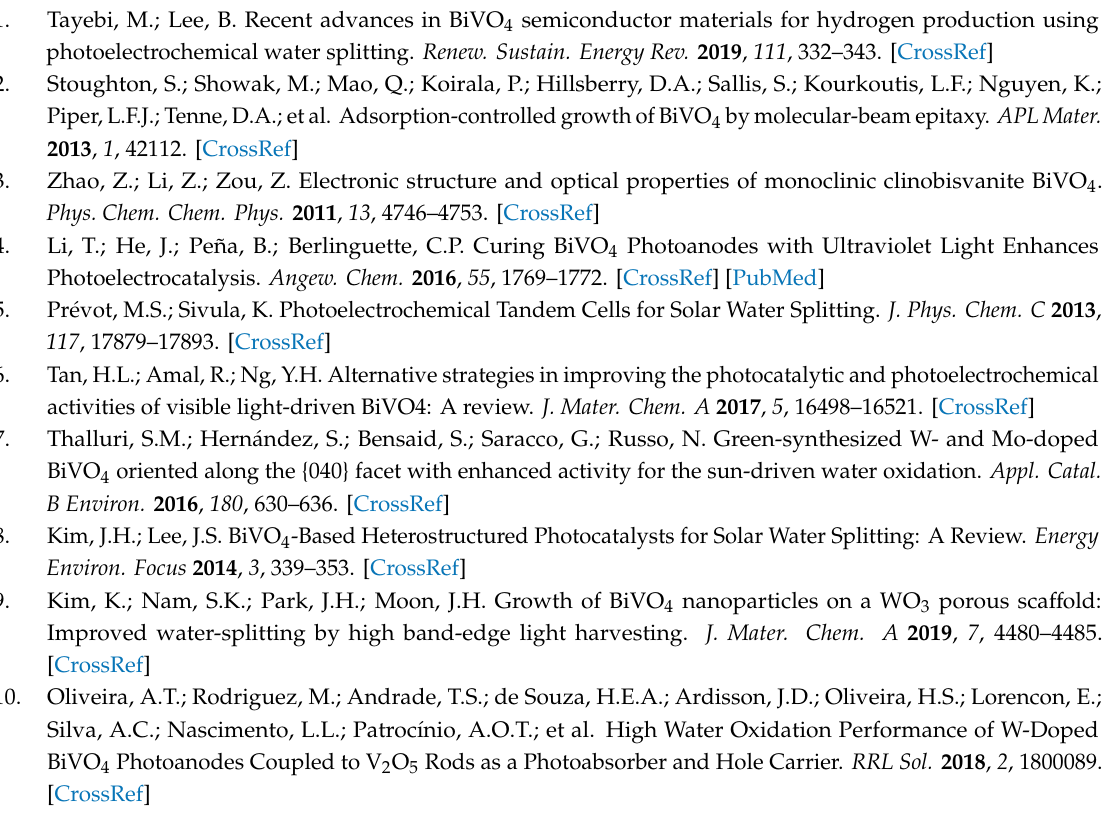
Figure S1: The self-made system for pulsed laser deposition. Figure S2: The exemplary cross-sectional SEM micrograph of the sample deposited under 0.1 mbar. Figure S3: The small-angle XRD patterns of the samples deposited under 0.1, 0.5, and 2 mbar. Figure S4: The EDX analysis of the V 2 O 5 crystals formed on the BiVO 4 film deposited under 0.5 mbar. Figure S5: The cross-sectional SEM micrograph of the area rich in longitudinal crystallites. Figure S6: The SEM image of the sample deposited under 2 mbar. Figure S7: AFM topography of films deposited under 0.1, 0.25, 0.5, 1, and 2 mbar. Table S1: The variation of the film thickness depending on the oxygen pressure and the distance from the